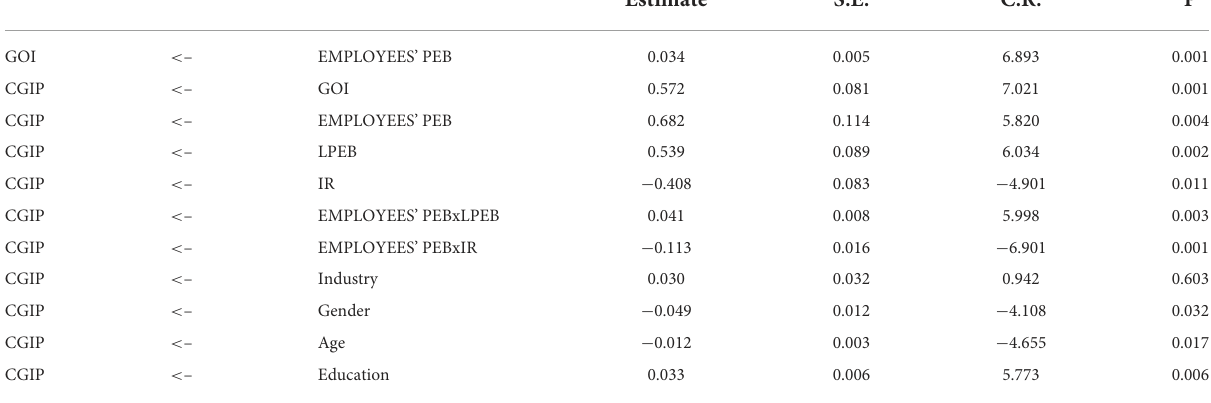
TABLE 3 Estimation results of